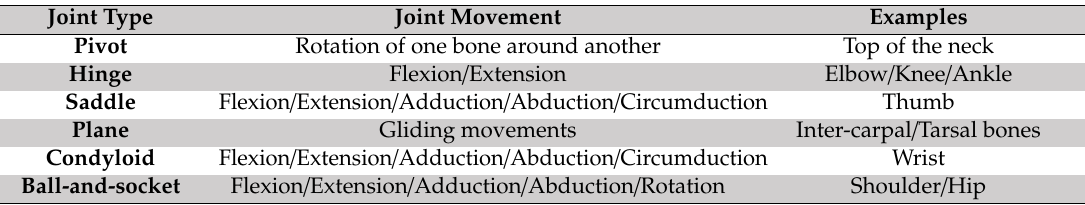
Table 1. Types of synovial joints.